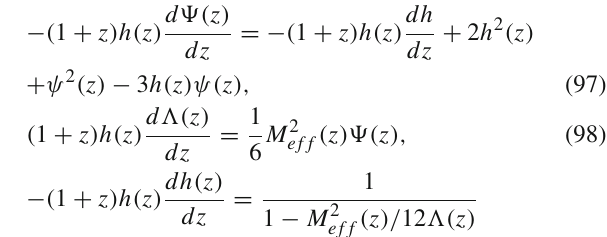
Fig. 8 Variation as a function of the redshift of the Weyl vector com- ponent (cid:18)( z ) for the geometry-matter coupling function F α ˜ Q ˜ T for M = 0 . 98, and for different values of α : α = − 0 . 72 (dotted curve), α = − 0 . 77 (short dashed curve), α = − 0 . 80 (dashed curve), α = − 0 . 81 (long dashed curve), and α = − 0 . 82 (ultra-long dashed curve). To integrate the system of cosmological evolution equations we have used the initial conditions h ( 0 ) = 1, (cid:18)( 0 ) = 0 . 455, and (cid:4)( 0 ) = 0 . 335